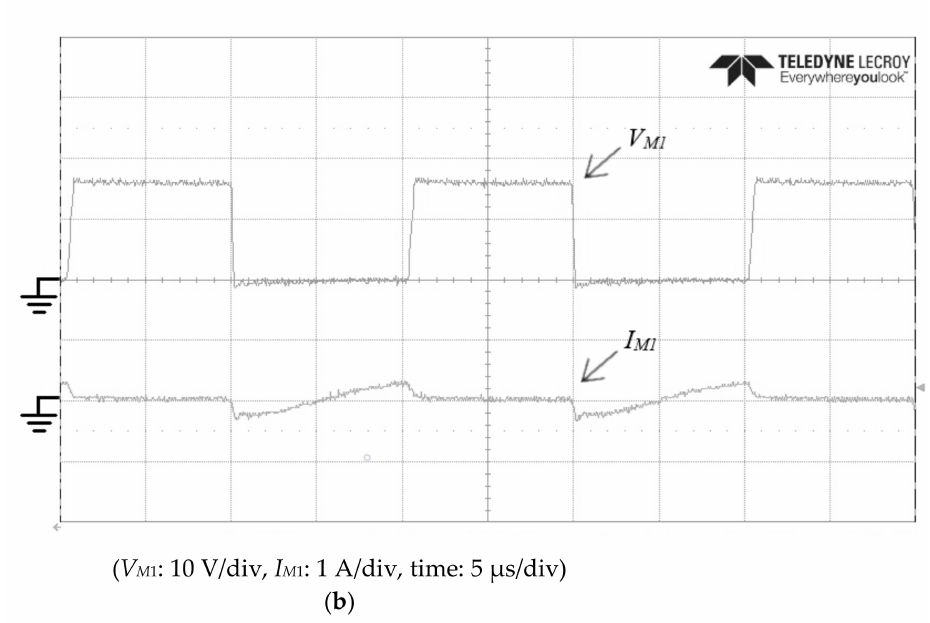
Figure 19. Measured voltage V M 1 , V M 2 and currents I M 1 , I M 2 waveforms of the proposed hybrid converter operated in the discharging mode: ( a ) voltage V M 2 and current I M 2 , and ( b ) voltage V M 1 and current I M 1 under 10% of full-load